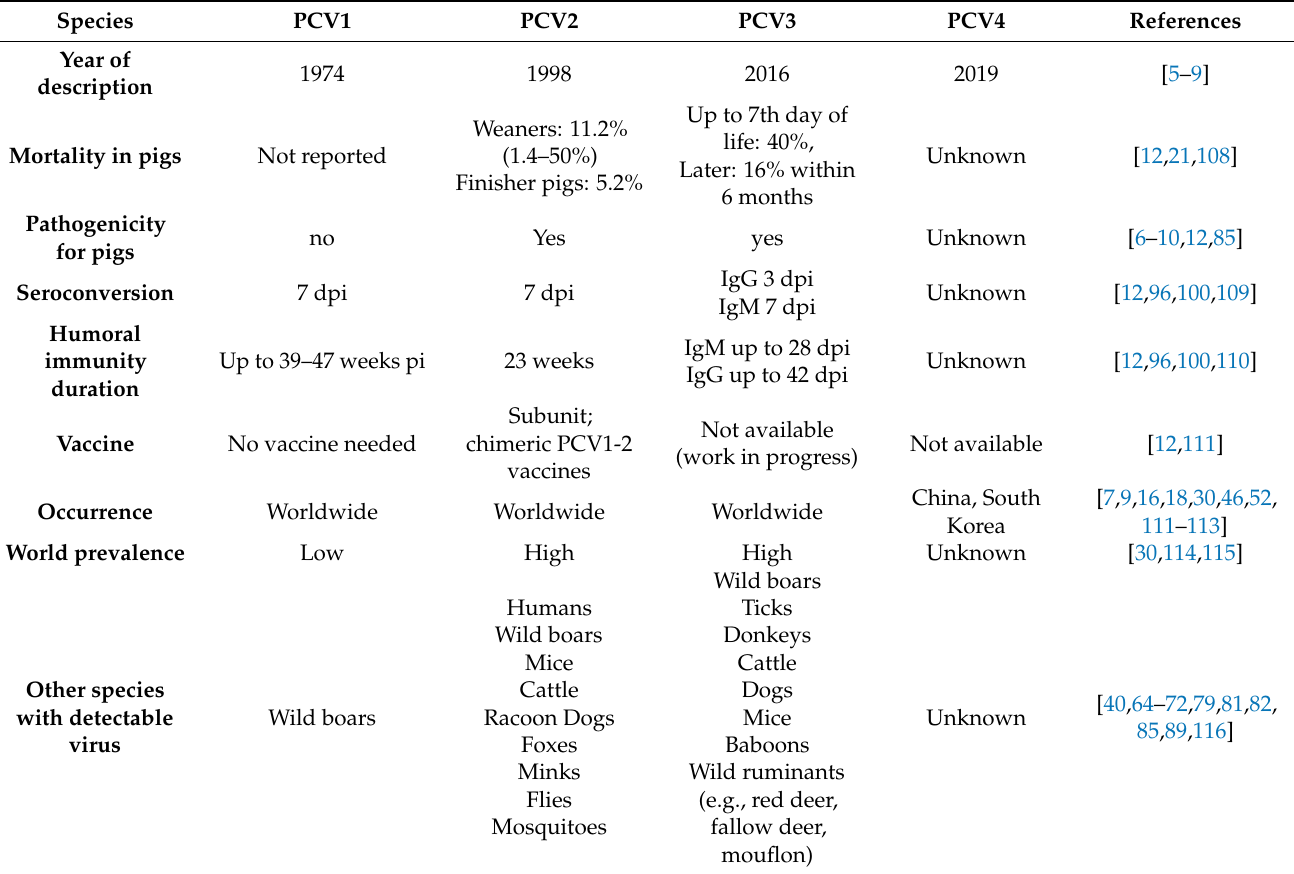
Table 1. Selected parameters characteristics for porcine